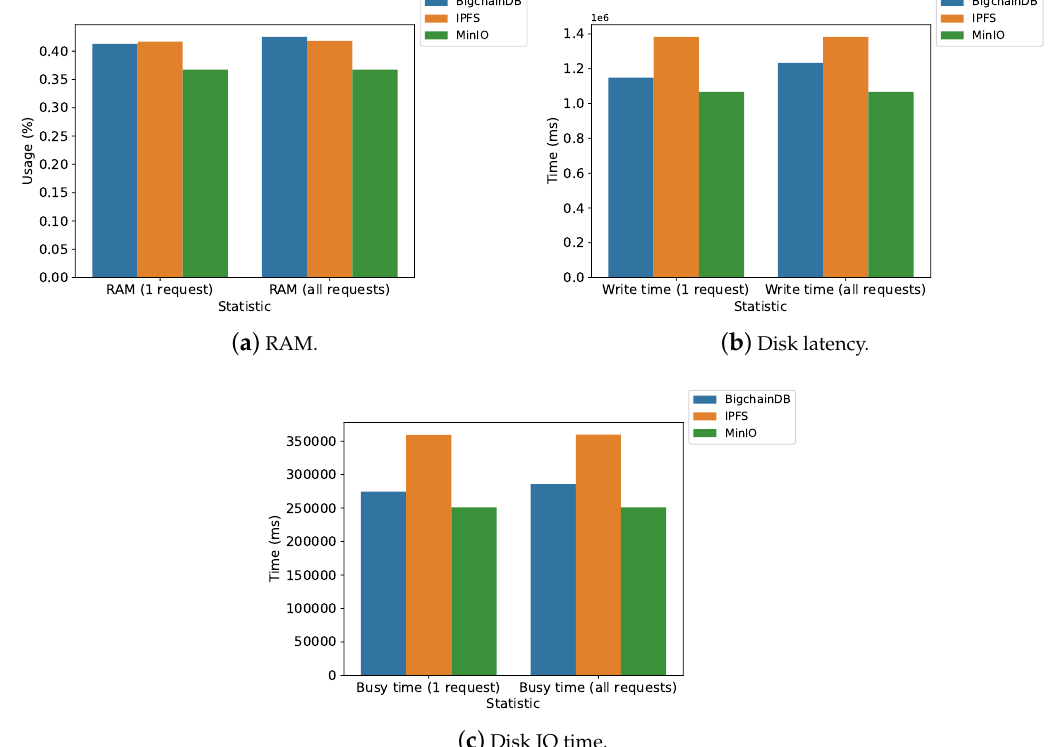
Figure 3. Statistics for the write operation of each